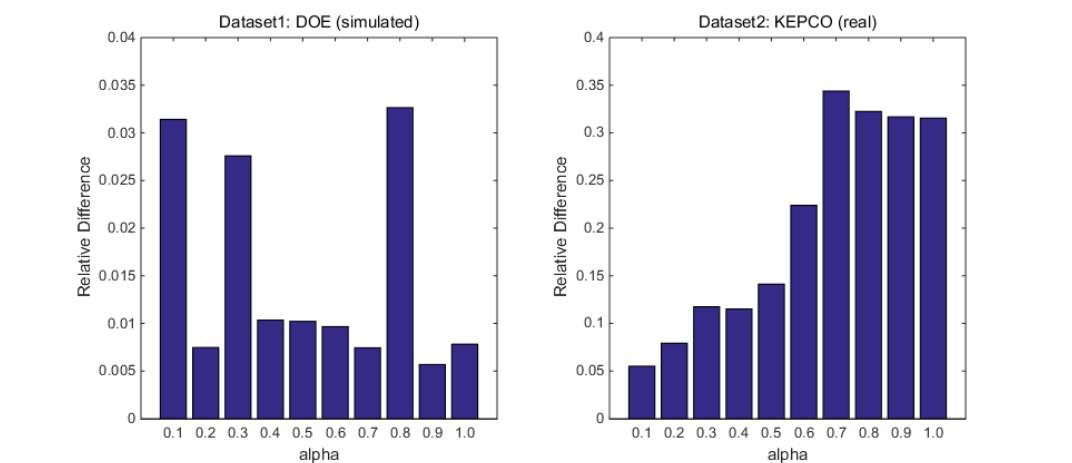
Figure 5. I RD index score comparison in relative difference. (positive prefers SPCC; negative prefers